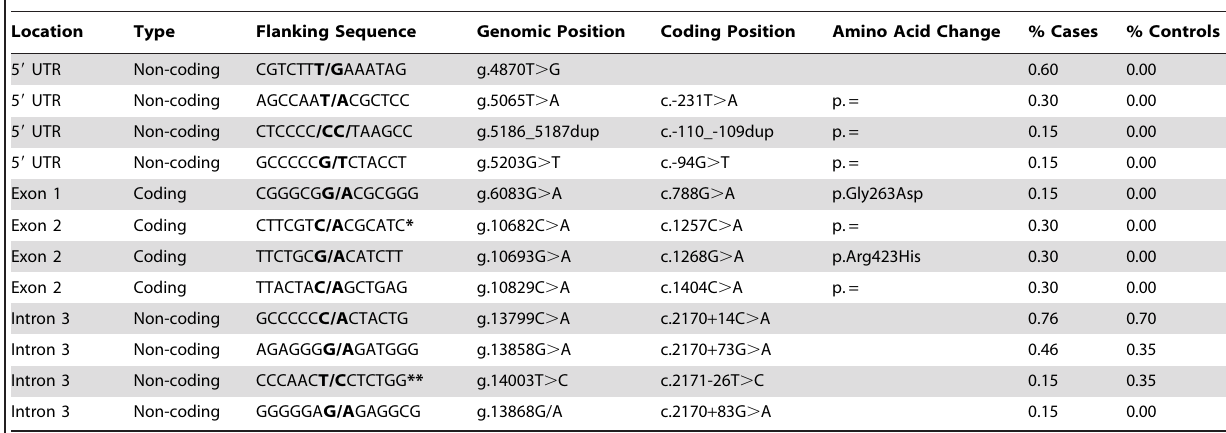
Table 1. Sequence Variants Found in Index